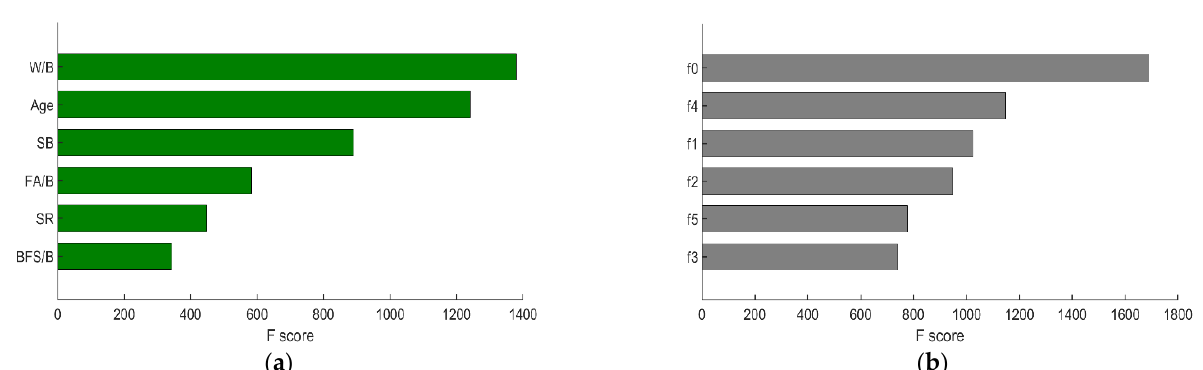
Figure 17. Feature importance of XGBoost model with 6 features: ( a ) manually selected features and ( b ) PCA-selected features.